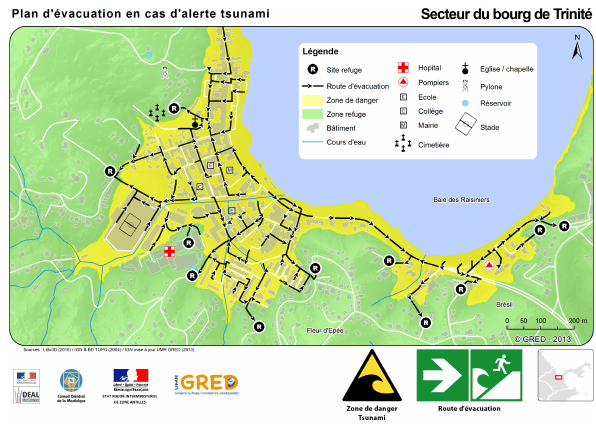
Fig. 6. Extract of evacuation map approved by the French Depart- ment of Civil Defense and Emergency Preparedness of Antilles Zone (EMIZA) (e.g. Trinité